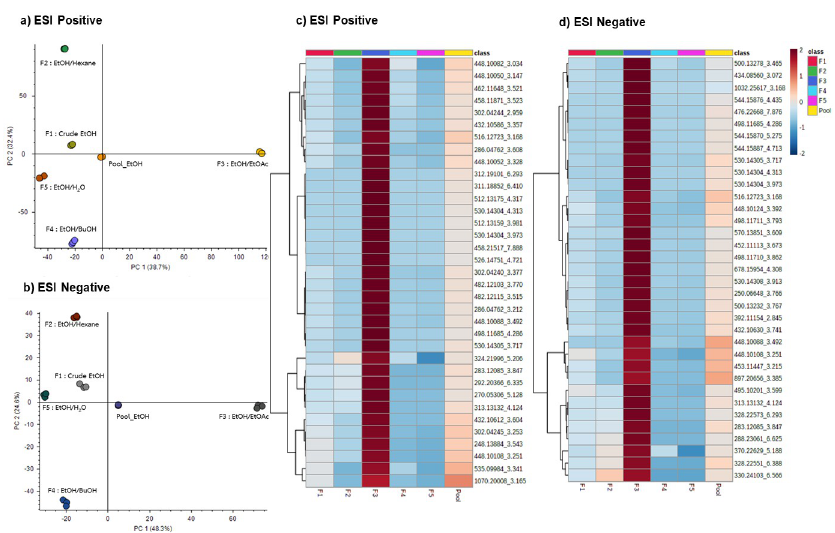
Fig 2. Principle component analysis and heat map visualization of X . tridentata extracts metabolic profiles. Principal component 1 (PC1) represents the maximal variation of data. Principal component 2 (PC2) is orthogonal to the PC1 axis and accounts for the second highest variation. a) Principle component analysis for ESI positive mode b) Principle component analysis for ESI negative mode. Each point represents an individual LC-MS injection. c) Heat map of 35 features with the highest fold change of F3/F5 observed in ESI positive mode and d) in ESI negative